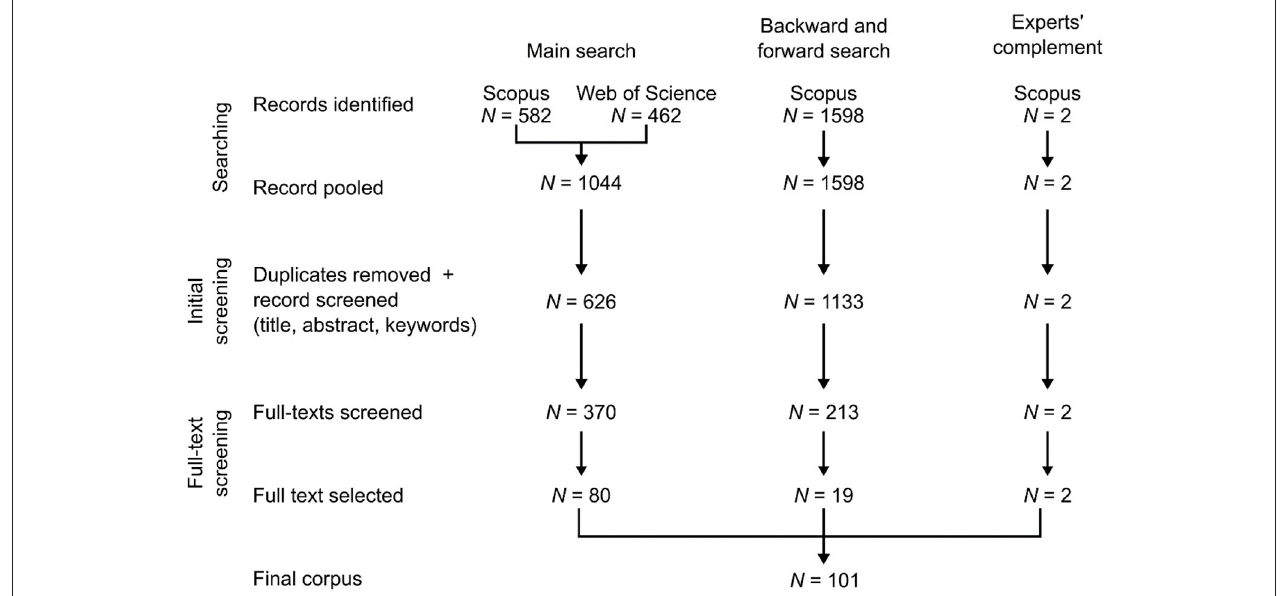
FIGURE 2 | PRISMA diagram of the systematic review conducted.